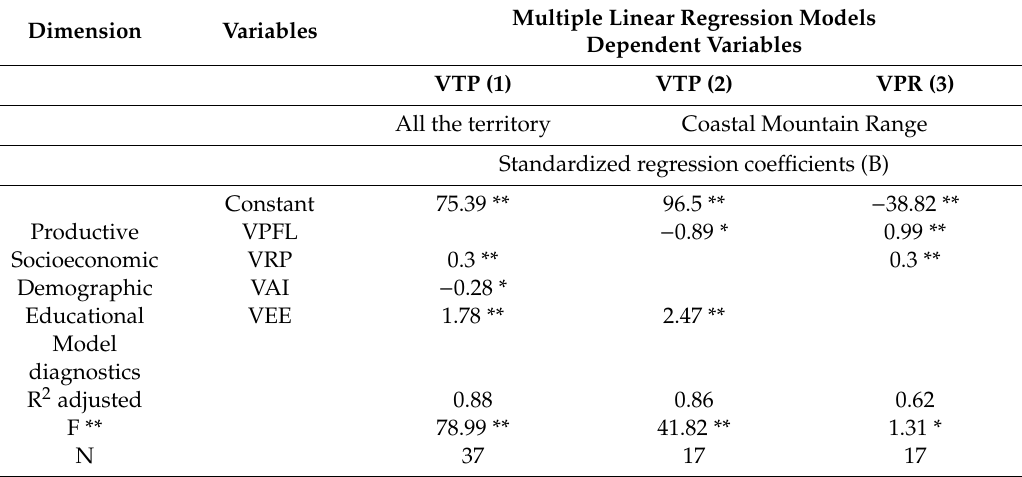
Table 3. Results of the regressions to identify the determining factors of territorial